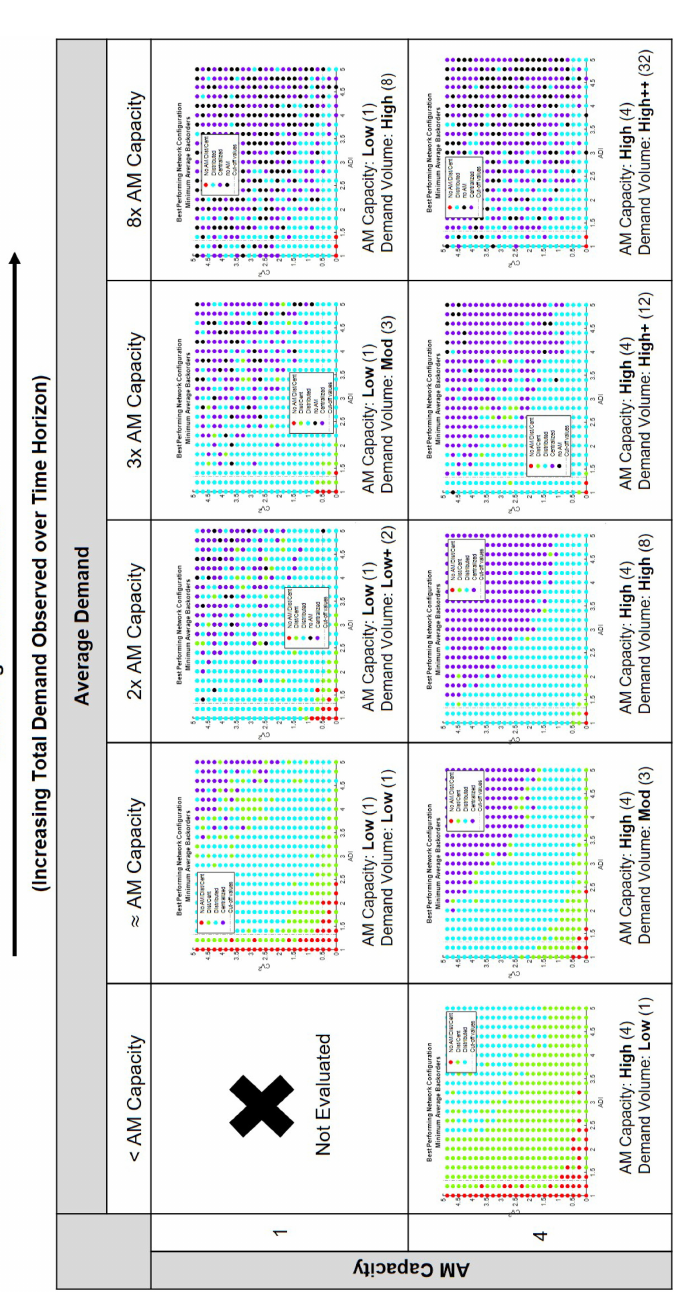
Figure 15. (Color online) Compares network performance and